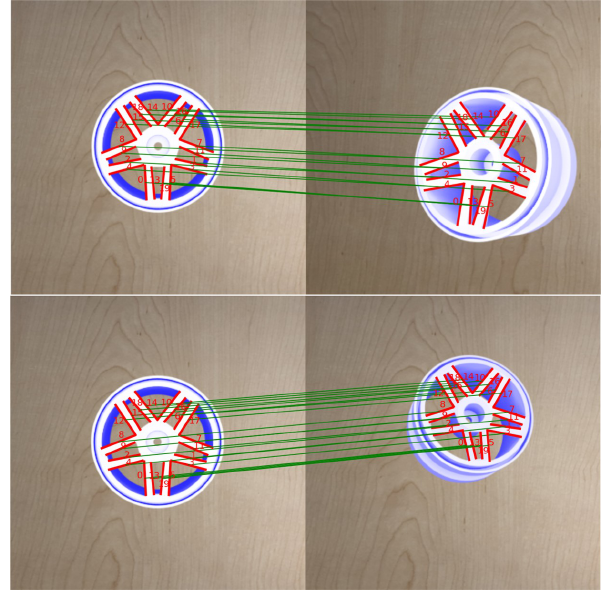
Figure 12. Line matching results of the proposed method. The left side shows the target image with detected line segments. The right side shows the current image. The green lines connect the correspondence line pairs between the target and current images.